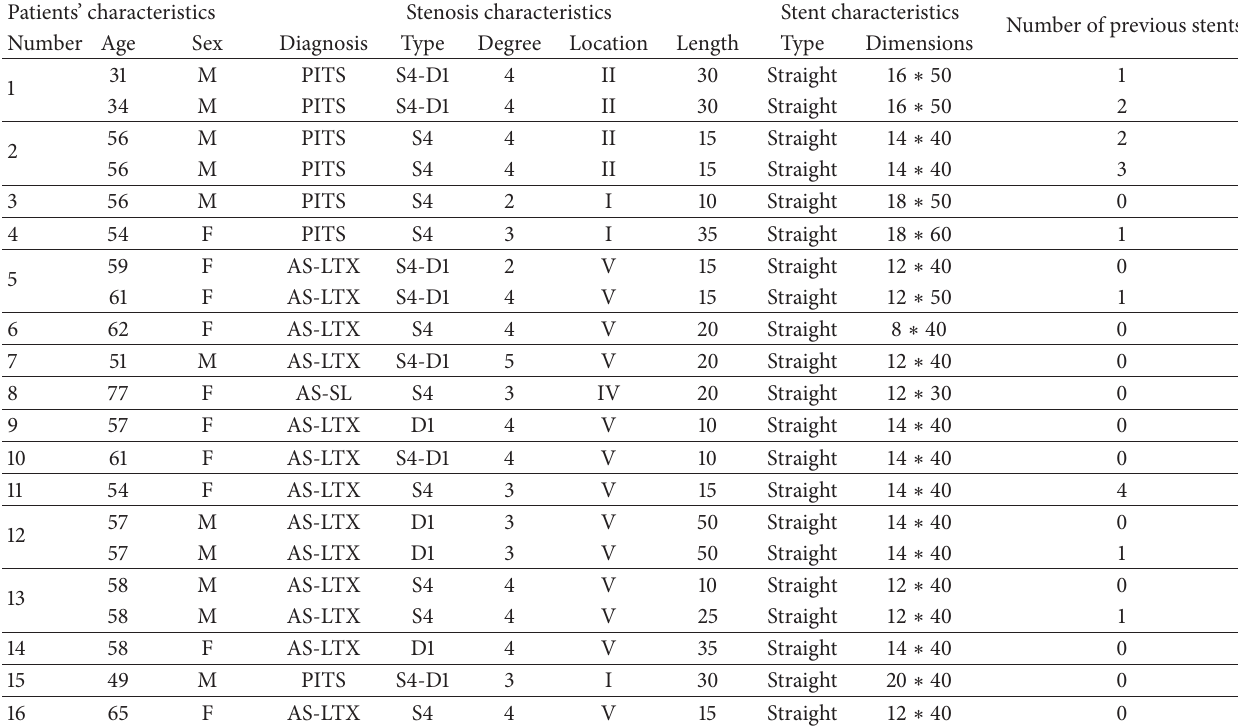
Table 1: Patients, stenosis, and stent